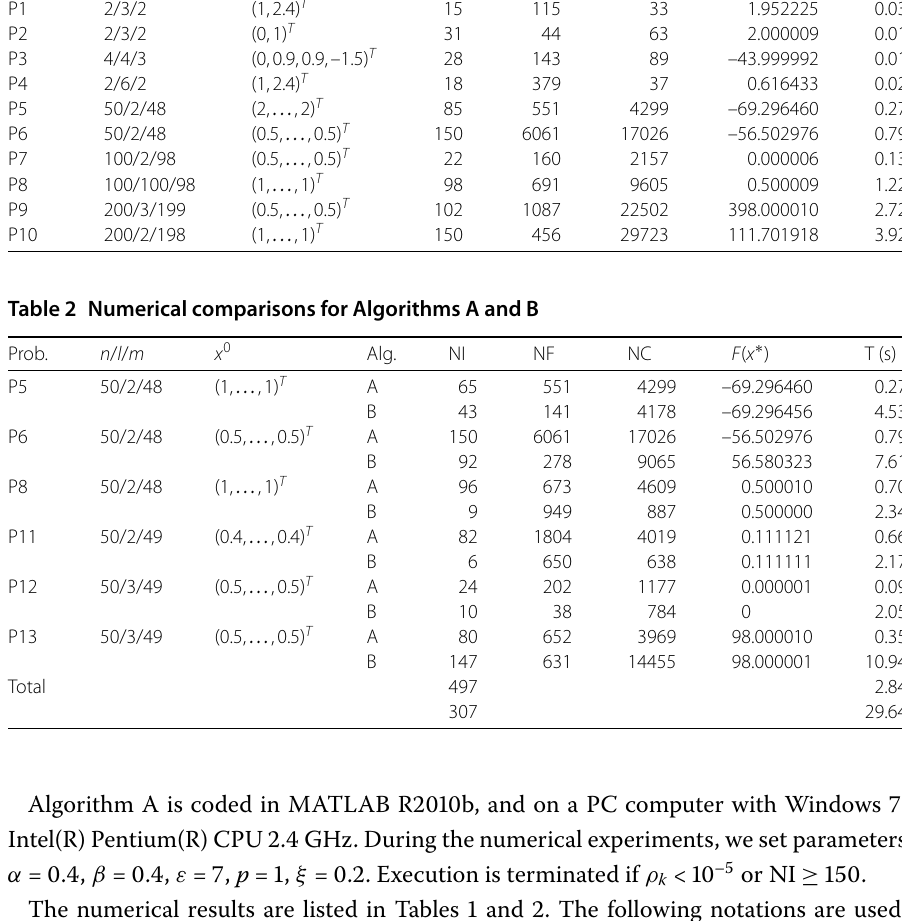
Table 1 Numerical results of Algorithm A Prob.